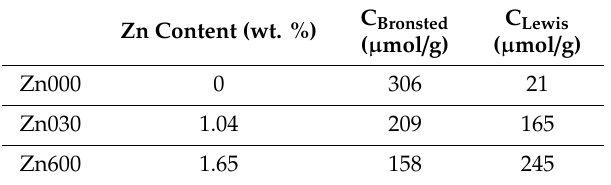
Table 1. Zinc loading measured by XRF analysis and concentration of Brønsted and Lewis acid sites determined from Fourier-transformed infrared spectroscopy (FTIR) using pyridine as a probe molecule. Zn Content (wt. %)